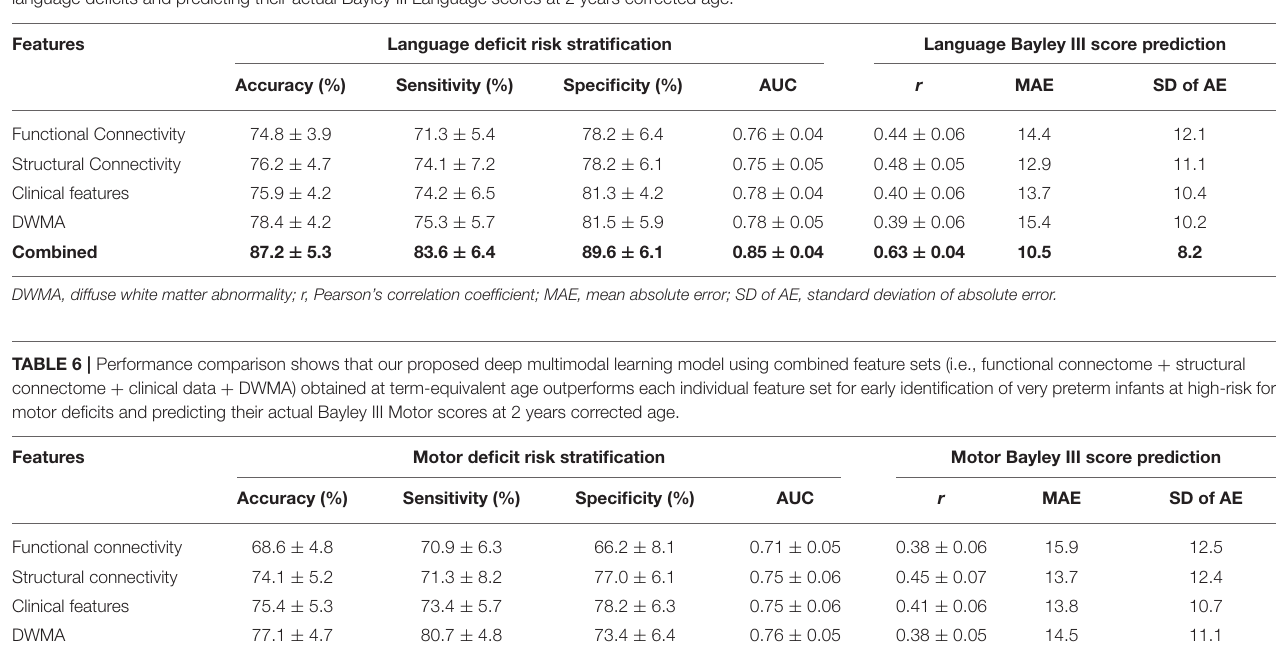
TABLE 5 | Performance comparison shows that our proposed deep multimodal learning model using combined feature sets (i.e., functional connectome + structural connectome + clinical data + DWMA) obtained at term-equivalent age outperforms each individual feature set for early identification of very preterm infants at high-risk for language deficits and predicting their actual Bayley III Language scores at 2 years corrected age.